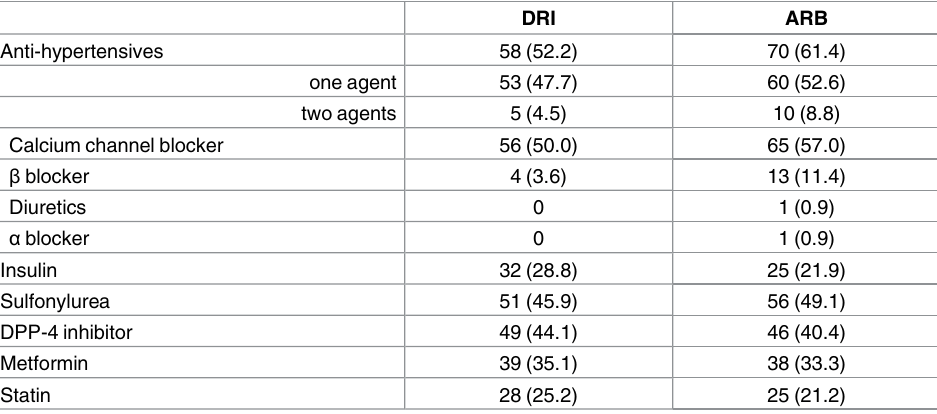
Table 1. Concomitant drugs at baseline.